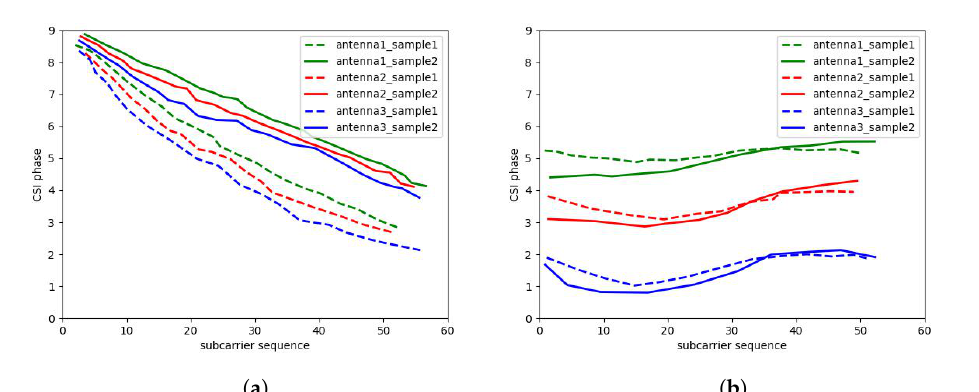
Figure 5. The correction of phase noise. ( a ) Original CSI phase. ( b ) Corrected CSI phase.